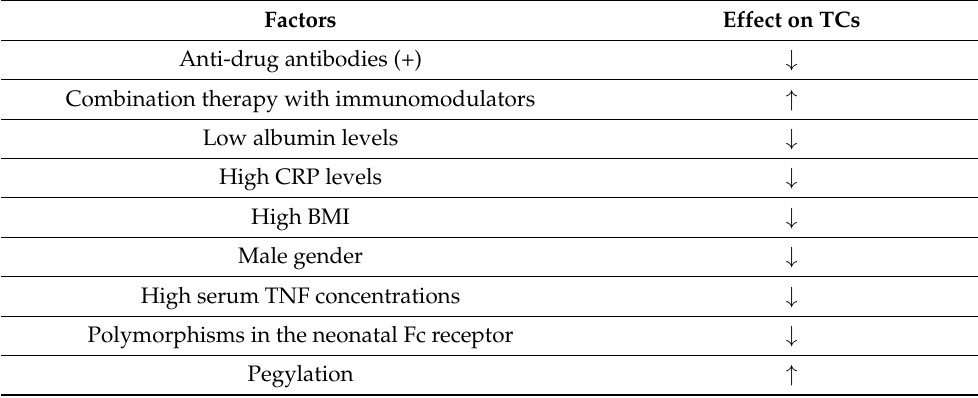
Table 1. Factors affecting the pharmacokinetics of anti-TNF agents [10,19,20].